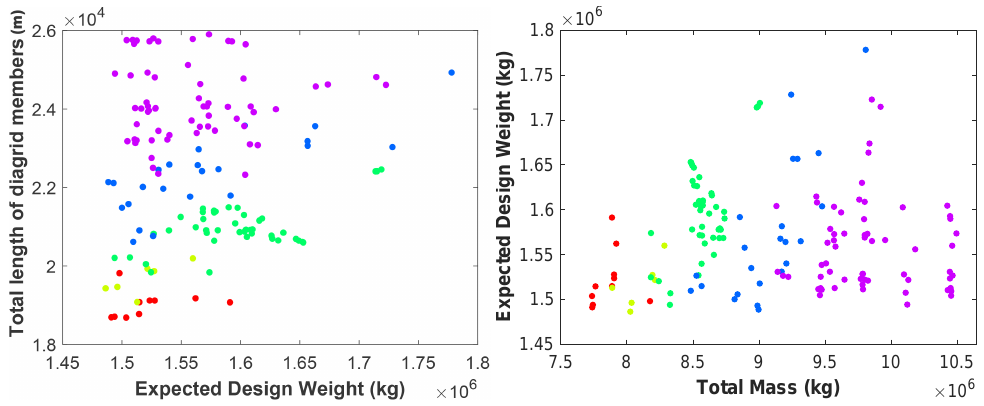
Figure 7. Projections on different feature planes of the 5-class representation of the structural